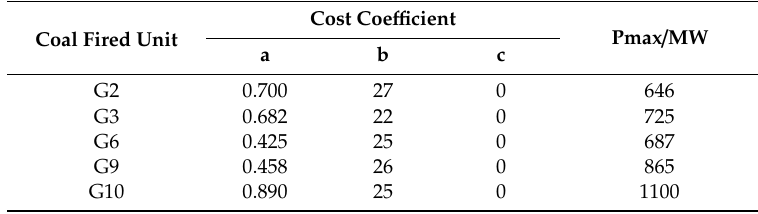
Table A2. Parameters of coal fired